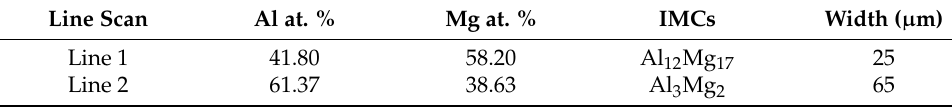
Figure 8. ( a ) STEM ZC micrograph of the interfacial layer between FSW 6022 Al and ZEK100 Mg; ( b ) XRD analysis that shows evidence of IMCs.